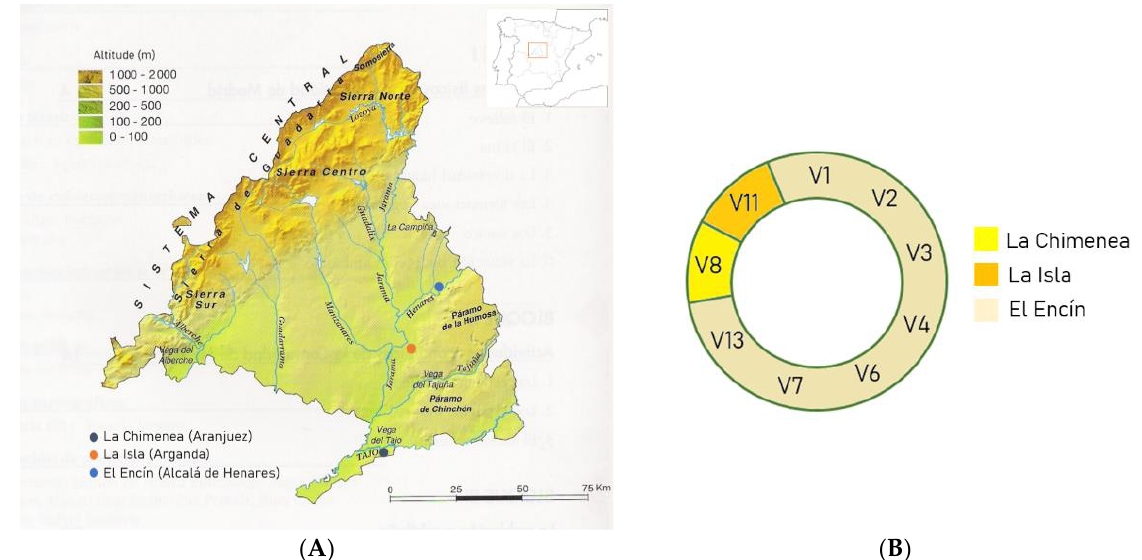
Figure 1. Location of the farms ( A ) and varieties used ( B ) in this study.